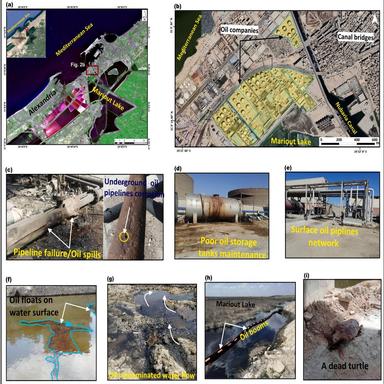
(a) Landsat 8 image showing the location of Alexandria. (b) Google Earth (GE) image showing the location of petroleum companies (c) Oil Pipelines failure/ corrosion and (d) Poor oil storage tanks maintenance and the resultant oil spills. (f and g) Occurrence of oil spills causing contamination of water bodies (i.e., (f) Nubaria Canal and (g) Mariout Lake). (h) Oil booms to contain oil slicks. (i) Sea turtle found dead at the oil-contaminated coastal marsh.